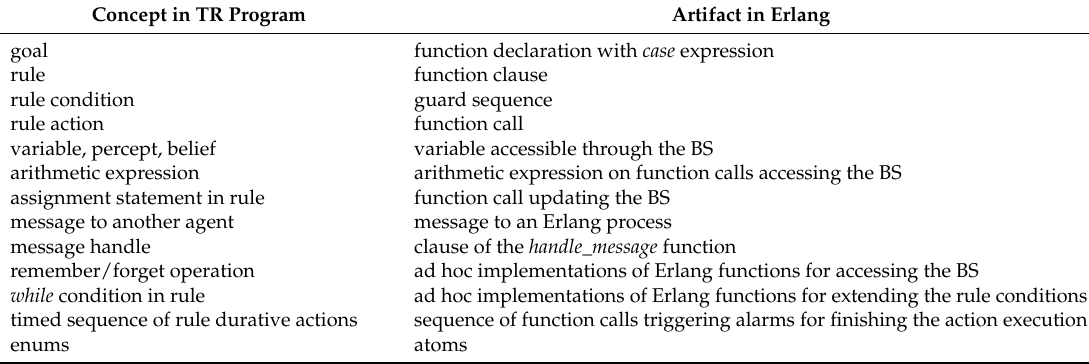
Table 14. Main correspondences between TR programs and the Erlang implementation.